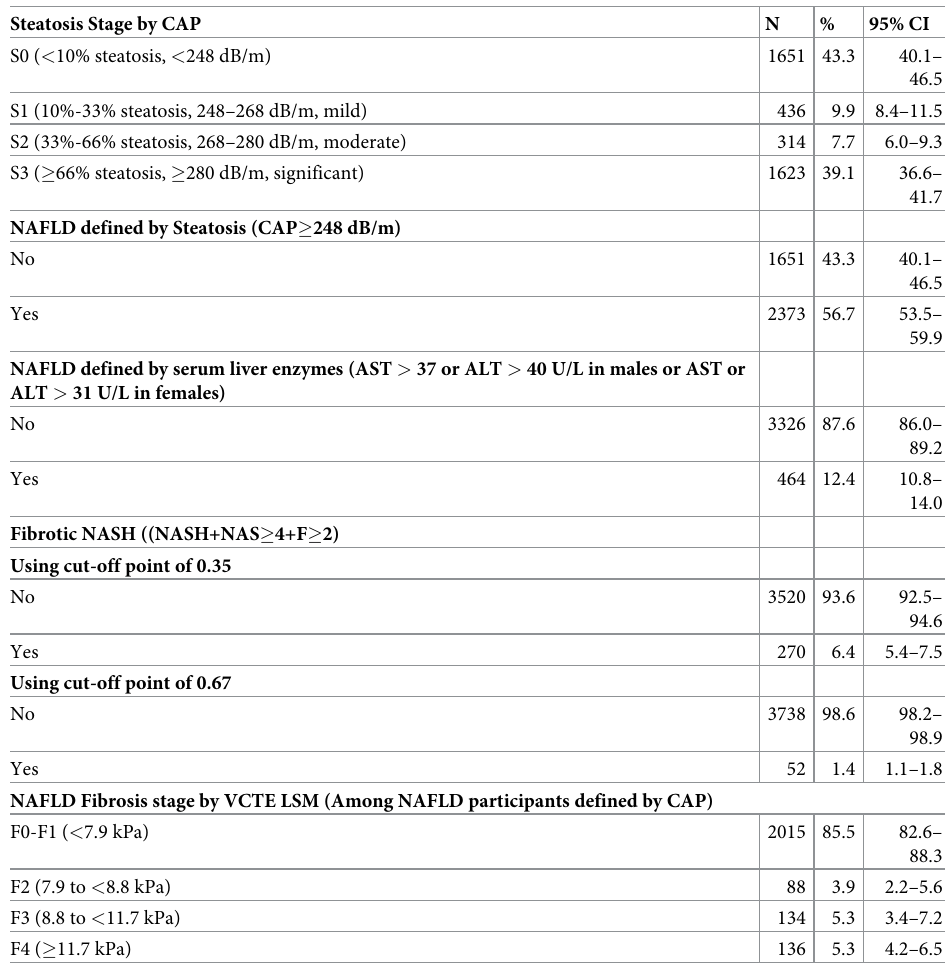
Table 2. Prevalence of steatosis stage, NAFLD defined by CAP, NAFLD defined by serum liver enzymes, fibrotic NASH defined by FAST (Fibroscan-AST) score and NAFLD fibrosis stage among NAFLD participants defined by VCTE